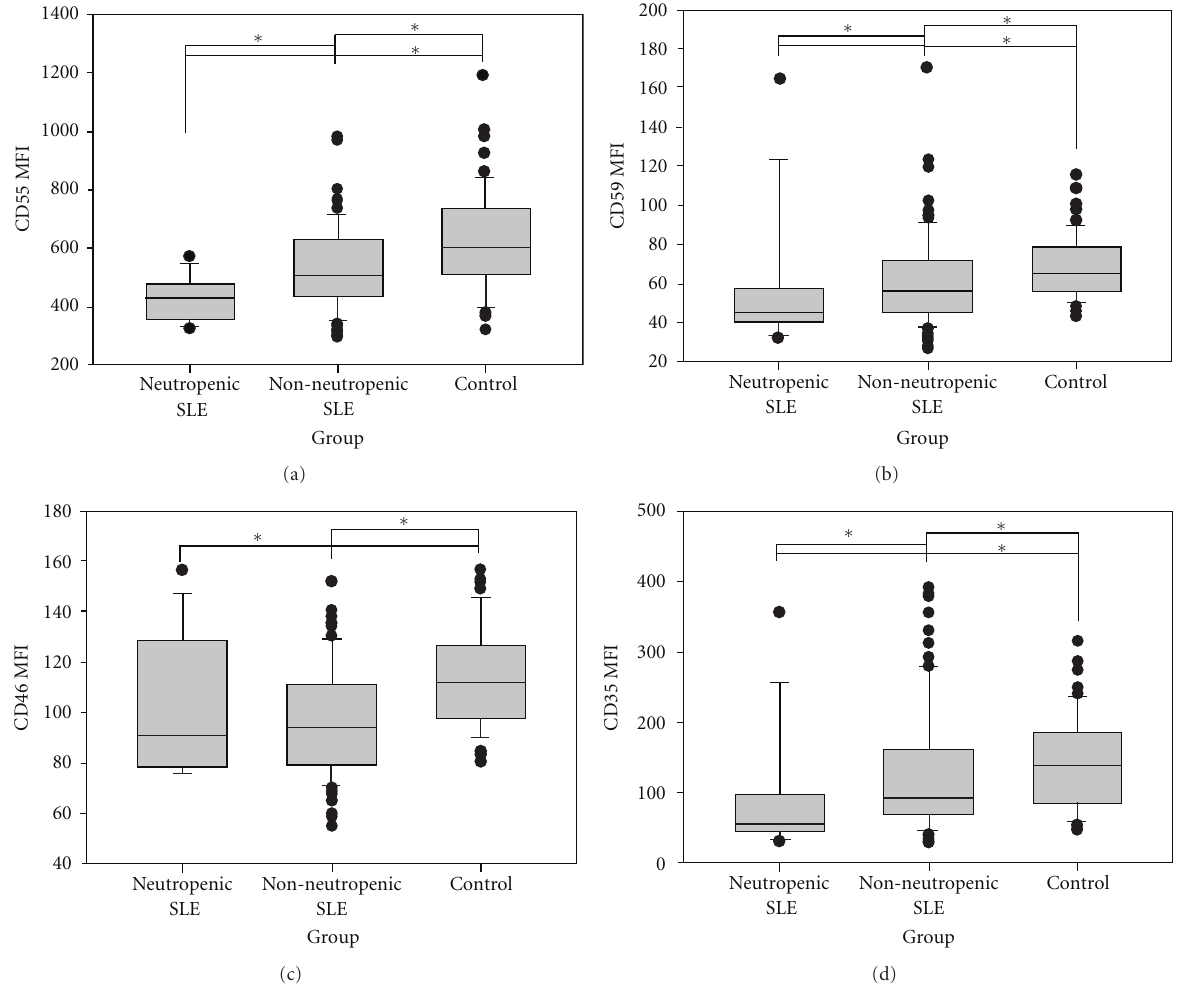
Figure 1: Creg surface expression of neutrophil cell. The figure displays mean fluorescence intensity (MFI) of CD55, CD59, CD46, and CD35 on gated neutrophil from SLE patients with neutropenia, without neutropenia and controls. Median and interquartile range from all subjects studied in each group were shown. ∗ Significant statistical di ff erence ( P < 0 .